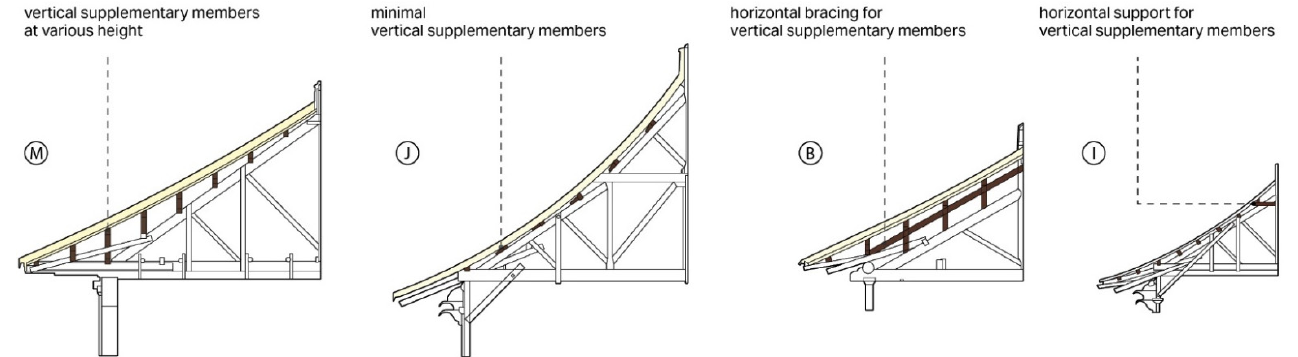
Figure 17. Roof Curve Created by Vertical Supports of Various Heights on the Top Chord.